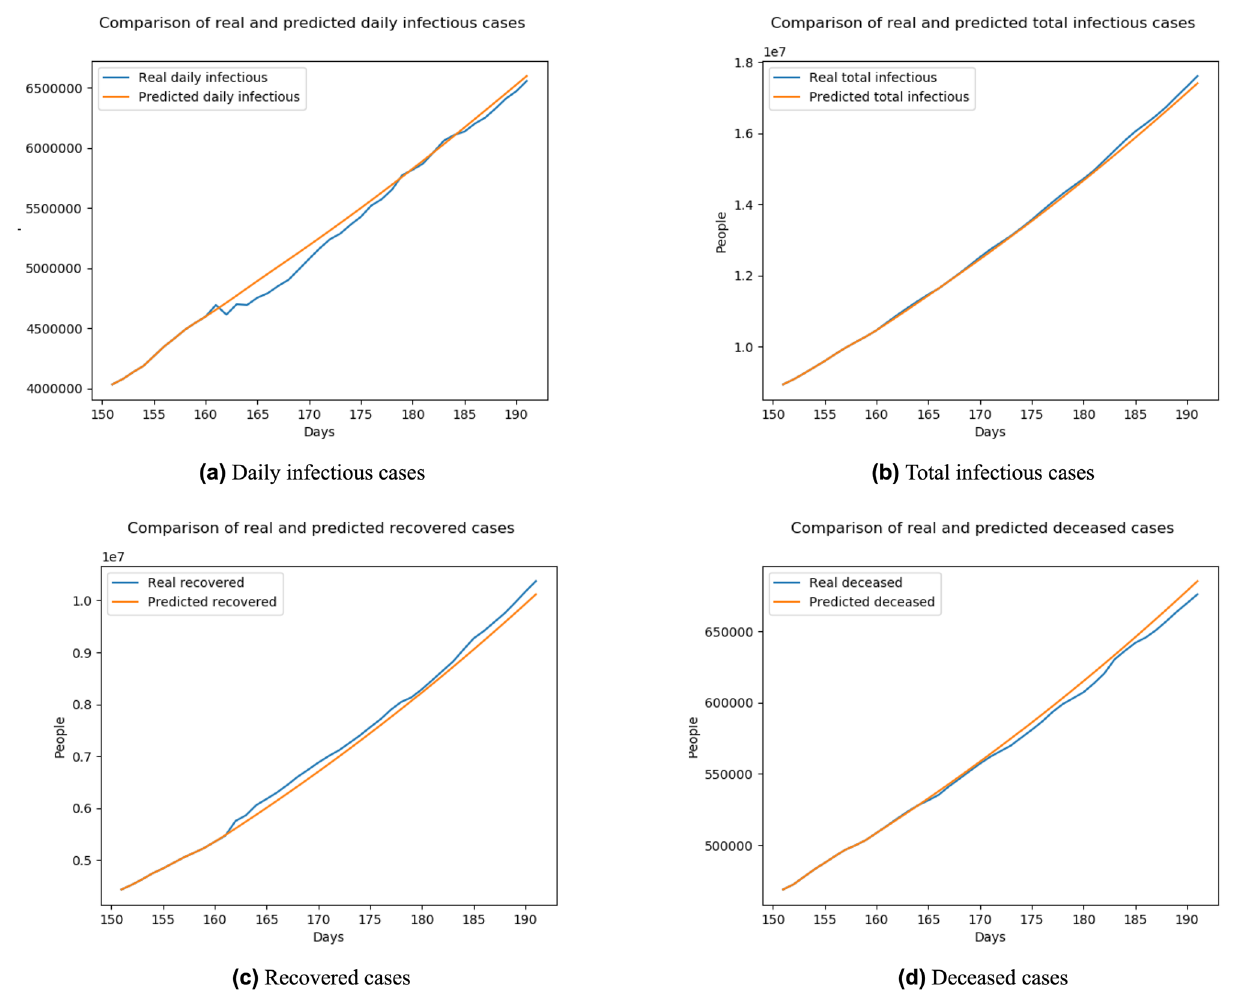
Figure 8. Comparison of the number of cases between real data and BeCaked forecasting results from 161st–191st day (Jul. 1st 2020–Jul. 31st 2020) of the